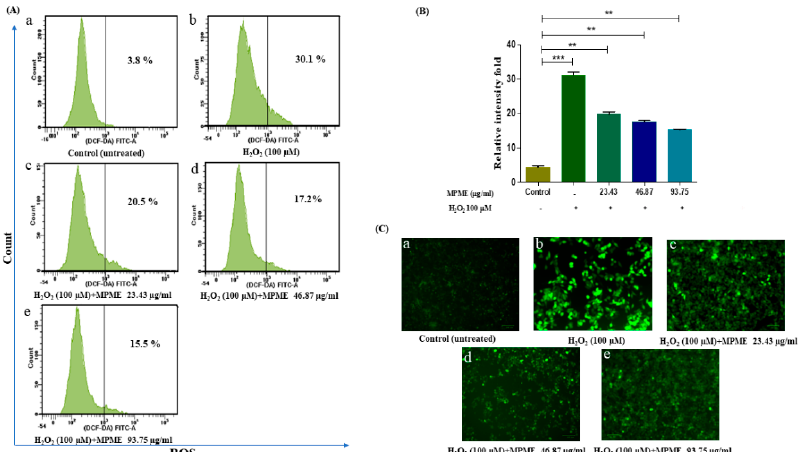
Figure 3. Flow cytometry analysis of intracellular reactive oxygen species (ROS) by H 2 O 2 -induced HepG2 cells, quantified by DCFH-DA probe. ( A ) Fluorescent intensity (ROS) of untreated and un- stimulated HepG2 cells (control) was 3.8% ( a ) H 2 O 2 induced cells was 30.1% ( b ) H 2 O 2 induced cells + 23.43 µg/mL MPME was 20.5% ( c ) H 2 O 2 induced cells + 46.87 µg/mL MPME was 17.2% ( d ) H 2 O 2 induced cells + 93.75 µg/mL MPME was 15.5% ( e ) respectively. ( B ) Relative intensity fold of DCFDA staining. The asterisks (*) indicate statistical significant differences with the control (** p < 0.01, *** p < 0.001). + and − indicate the presence and absence of MPME/H 2 O 2 -100 µ M ( C ) Fluorescence microscopy images (20 × ) of MPME stained with DCFDA to visualize ROS accumulation. In MPME treatments for 24 h, a decline in ROS generation compared to H 2 O 2 stimulated cells was